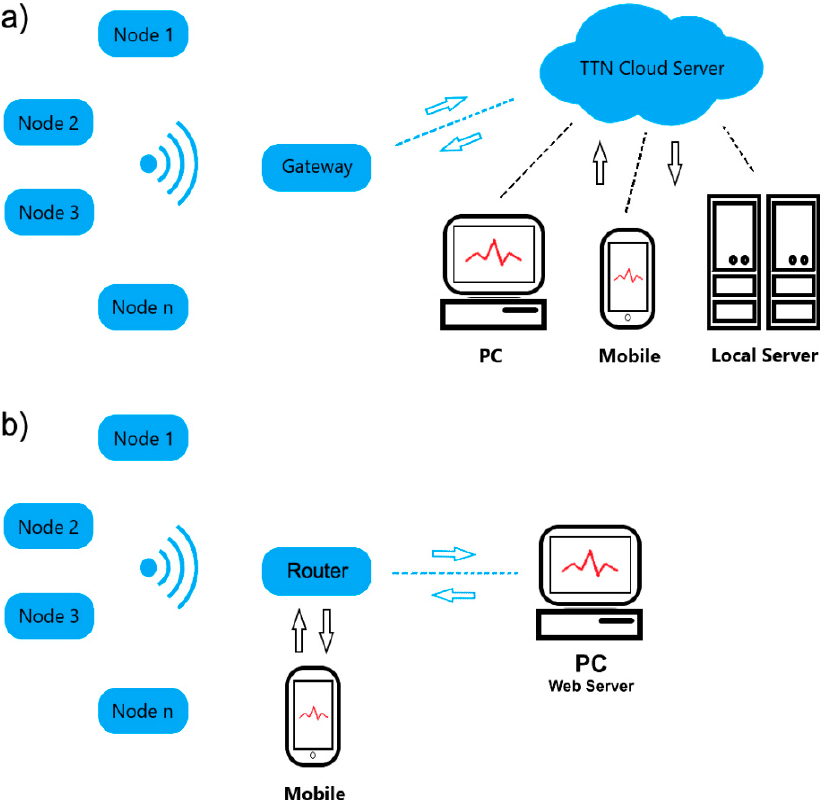
Figure 12. Sensor network operation scheme: ( a ) long range (LoRa) via The Things Network (TTN) cloud server [48], industrial scale or PaaS, ( b ) individual homestead, small-scale short-range.